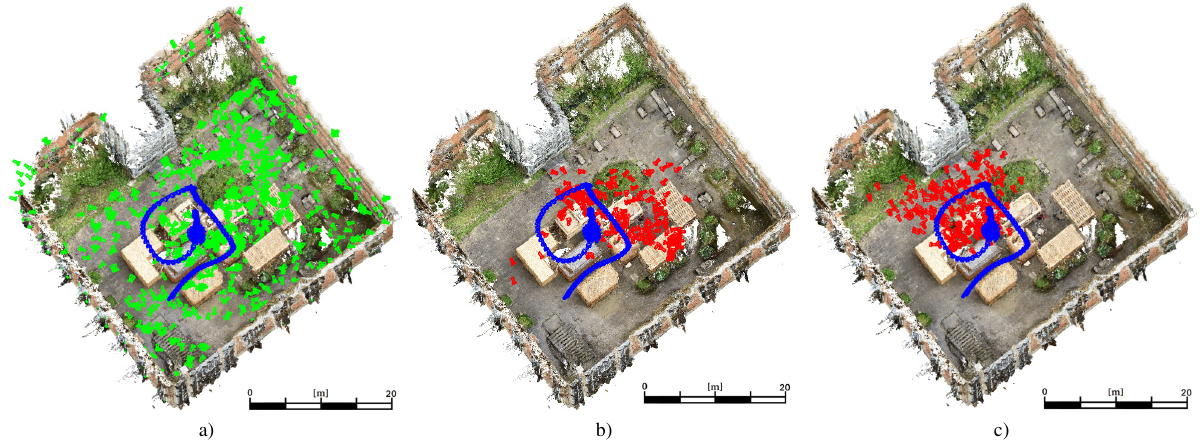
Figure 8. Atrium data set, low coverage sequence . a) Visualization of ground truth, b) results derived by the CNN adaptation of VGG16-Net, c) results derived by SqueezePoseNet. Green cameras indicate training data, blue cameras depict the ground truth and red cameras are estimated poses derived by the modified CNNs.